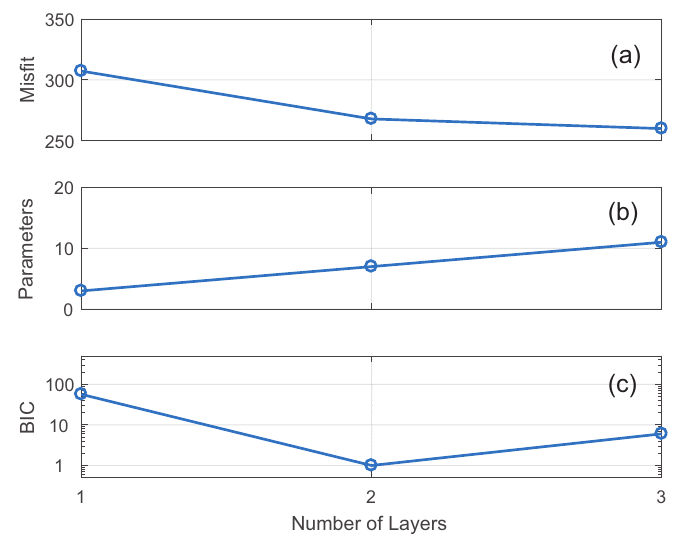
Figure 6. The results of model selection. ( a ) misfit, ( b ) number of parameters, ( c ) BIC values of different models. For display purposes, BIC values shifted so the minimum is at unity and plotted on a log scale.